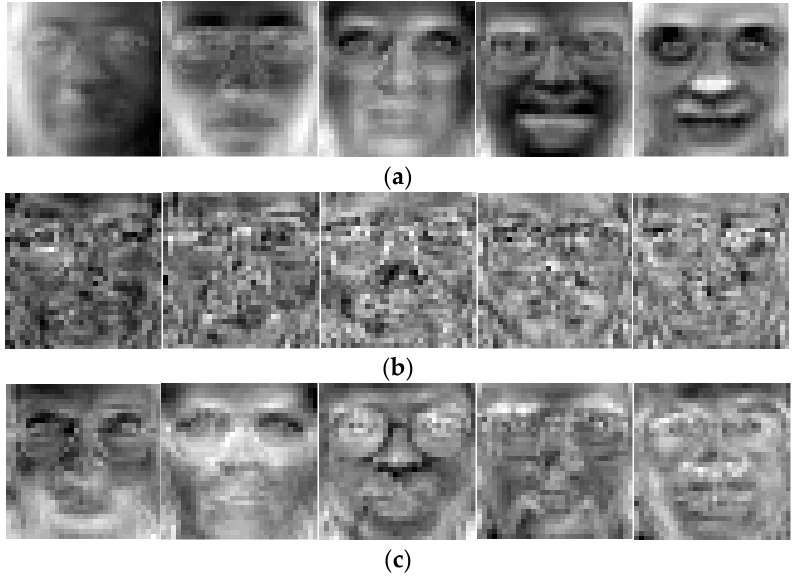
Figure 8. The first five basis vectors calculated by ( a ) PCA (Eigenfaces); ( b ) LDA (Fisherfaces); ( c ) BLSE (BLSEFaces) on ORL dataset.